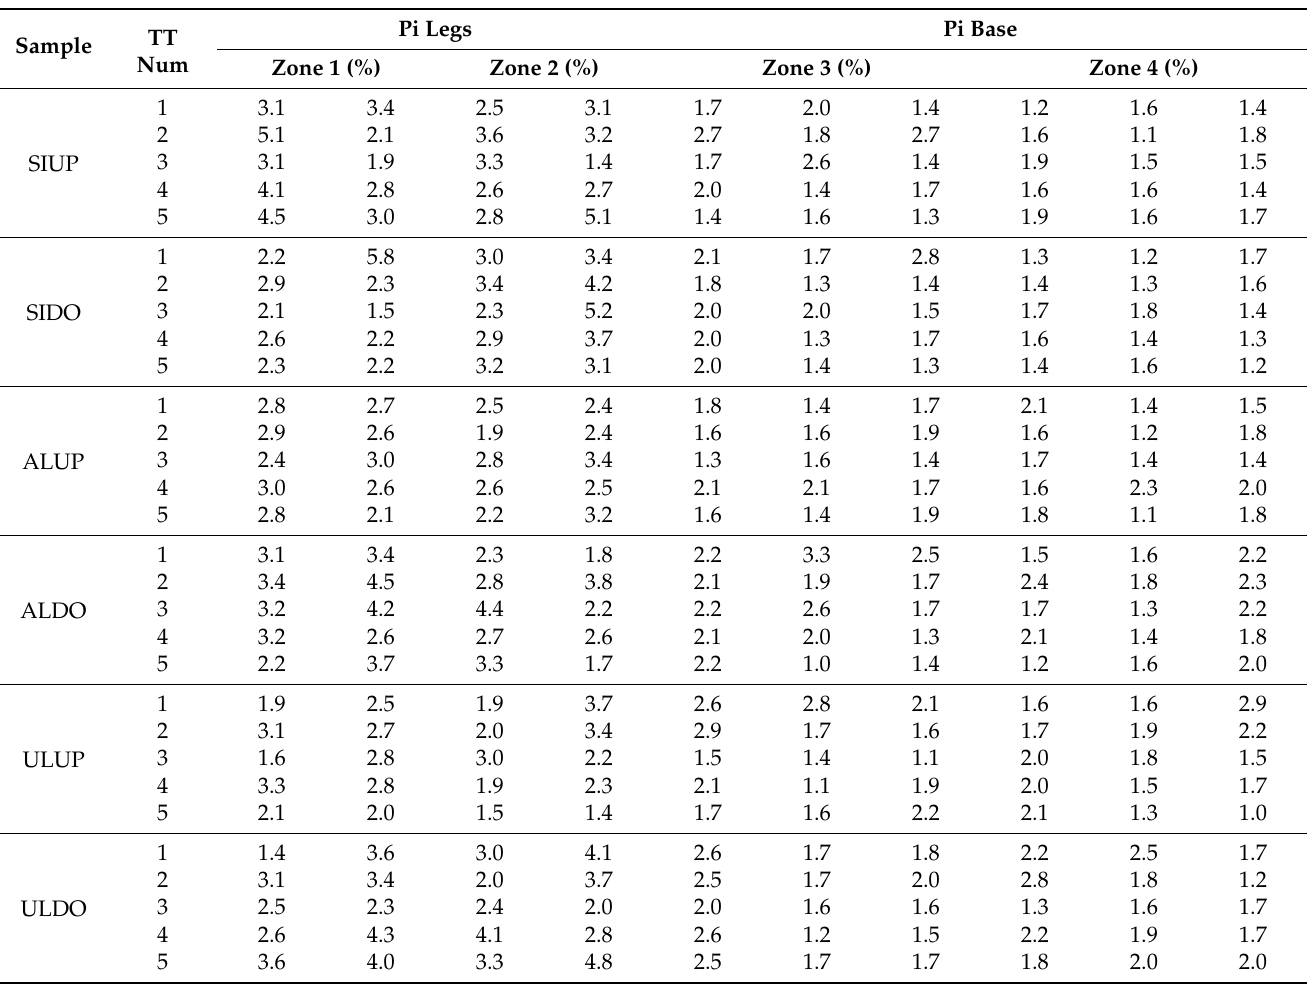
Table 3. Measured crimp (%) used for creating control